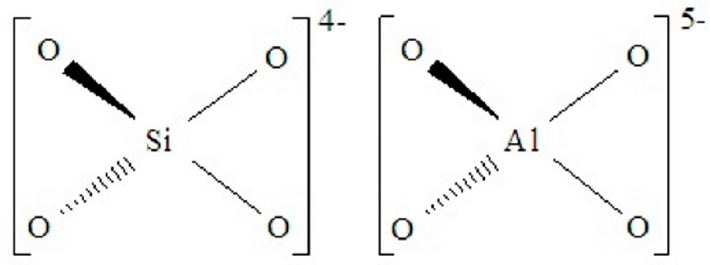
Figure 3. Tetrahedral arrangement of SiO 4 and AlO 4 which forms the primary building units of zeolite. Reproduced from Reference [63] under CC BY 4.0.